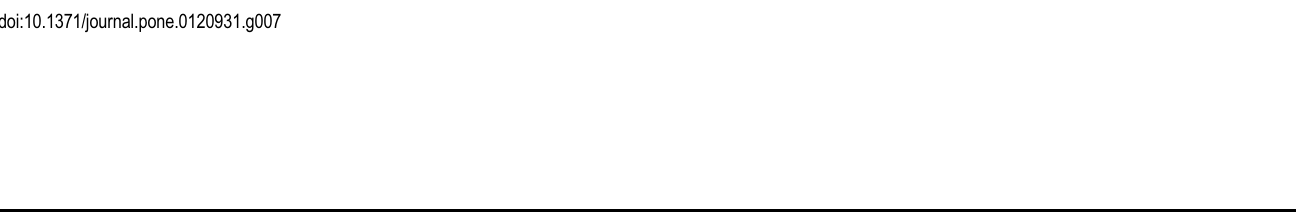
Fig 7. Chromatogram of residual crude oil in polluted water A) with 1% oil, B) With 2% oil, C) control with 1% oil, D) control with 2%